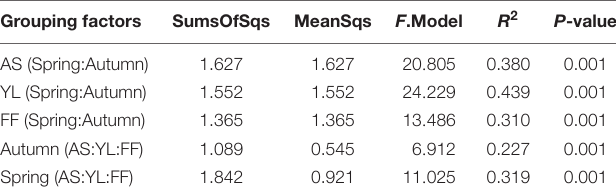
TABLE 3 | PERMANOVAs exploring the effects of different bamboo species (AS, A. spanostachya ; YL, Y. lineolate ; and FF, F. ferax ) and seasons (Spring and Autumn) on the phyllosphere bacteria community based on Bray–Curtis distance